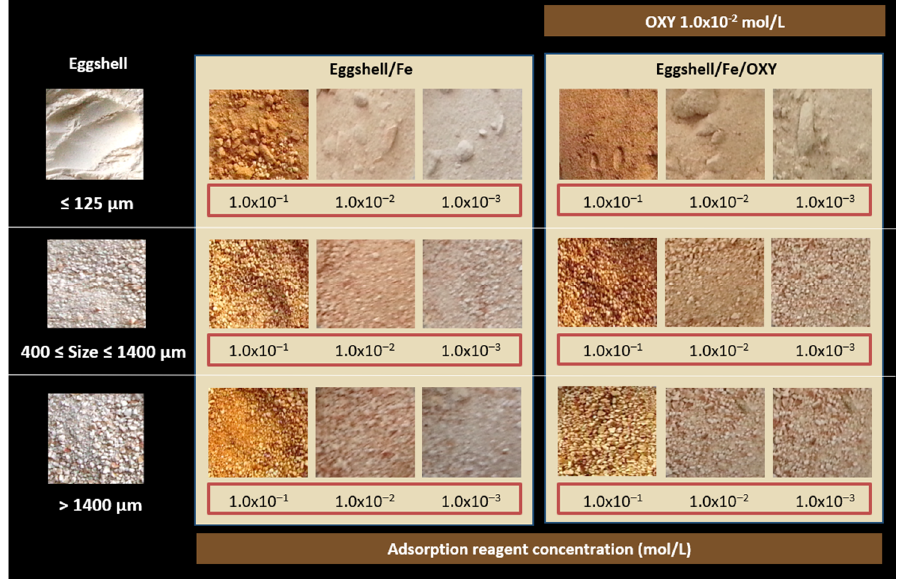
Figure 3. Effect of metal concentration ranging from 1.0 × 10 − 3 to 1.0 × 10 − 1 mol/L on the prepara- tion of iron-based eggshell sensing materials having different particle sizes and a fixed concentration of